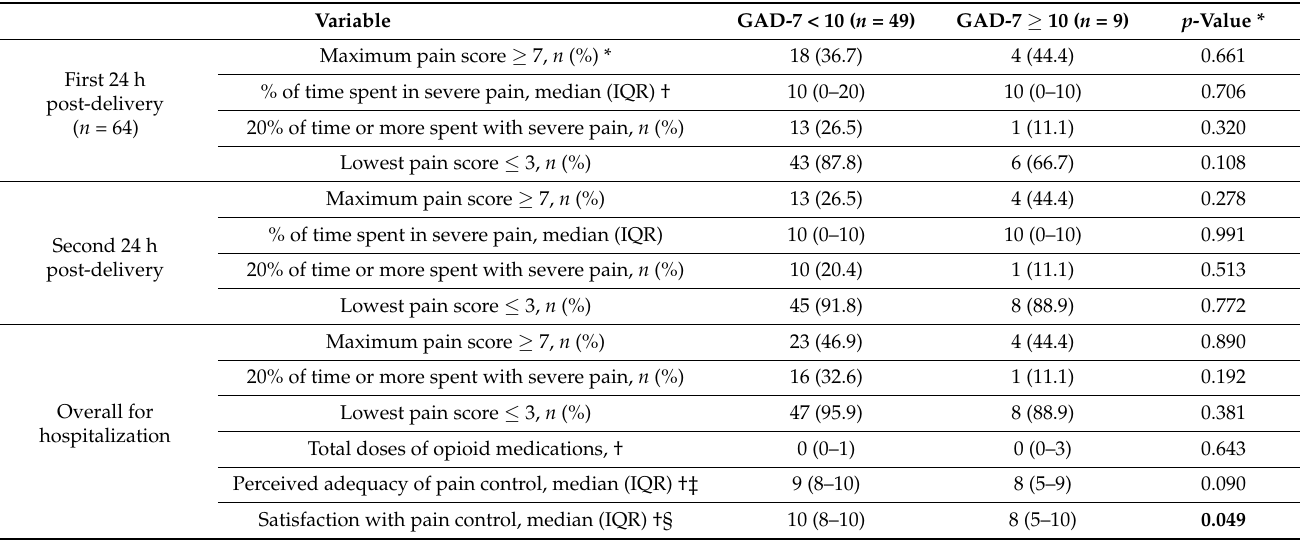
Table 6. Associations between pain and anxiety for participants in the 6-week postpartum sur- vey. Minimum, maximum pain scores in the first and second 24 h time period and for the whole hospitalization, and percentage of time spent in severe pain, per patient